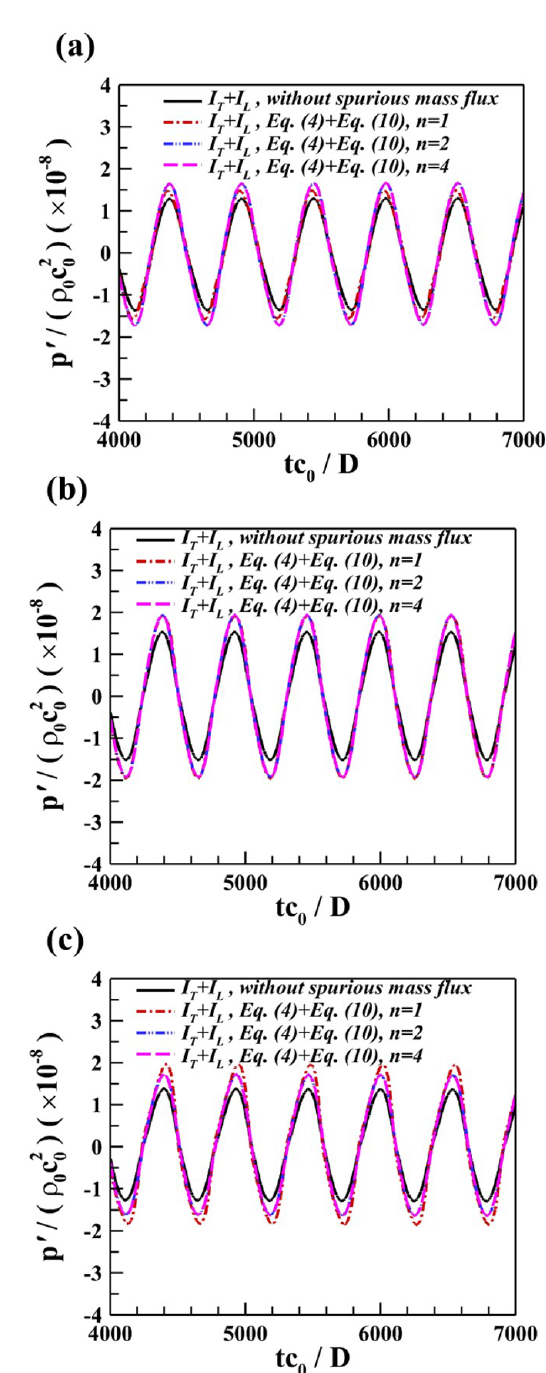
Figure 8. Acoustic pressure calculated by summing Equations (4) and (10) for n = 1,2,4 with spurious mass flux on the integral boundary at the observer: ( a ) 1000 D ( b ) 1000 D